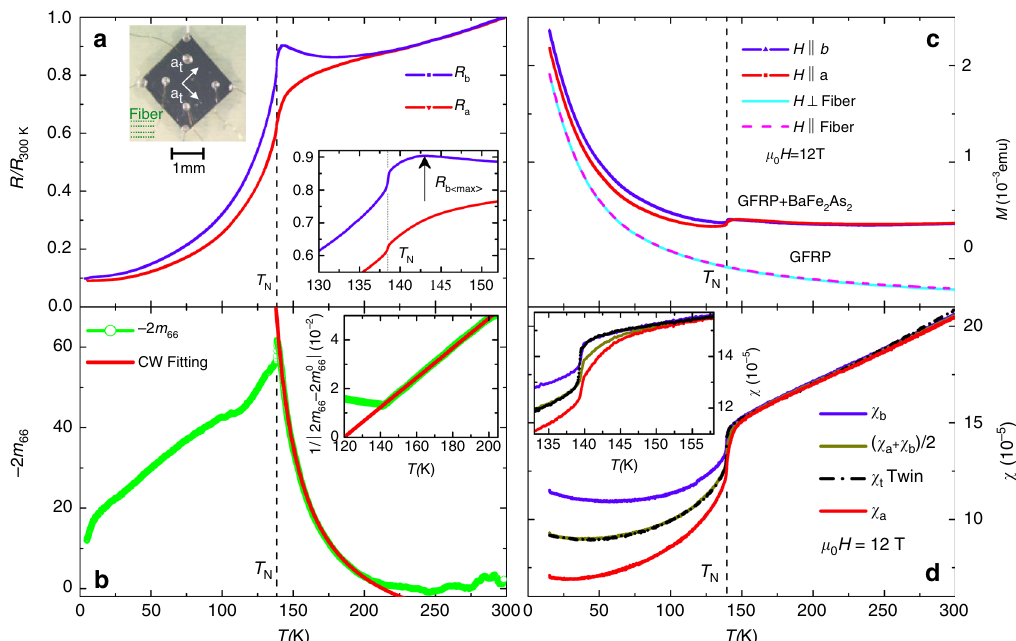
Fig. 2 In-plane resistance and susceptibility anisotropies. Temperature dependence of a the in-plane resistances along a and b directions, b the elastoresistivity tensor 2 m 66 , c raw magnetization data of GFRP alone and together with the BaFe 2 As 2 crystal, and d anisotropic susceptibility obtained by subtracting the GFRP background from the data shown in c . The red solid line in b is a Curie – Weiss fi t ( | 2 m 66 | = a /( T − T 0 ) + b with T 0 = 120 ± 1 K) and the inset shows the inverse plot. The inset in a , d displays magni fi ed views near T N . The arrow in the inset of a indicates a maximum of R b . The photograph in a illustrates the contacts con fi guration of the resistance measurements